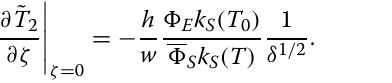
The dimensionless solution of Eq. (35) corresponding to the solution T 1 of Eq. (33) is given by where T = and this corresponds to a solution outside boundary lay-